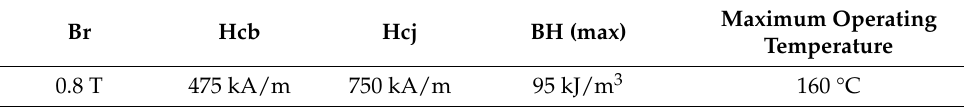
Table 2. Magnetic material parameters.